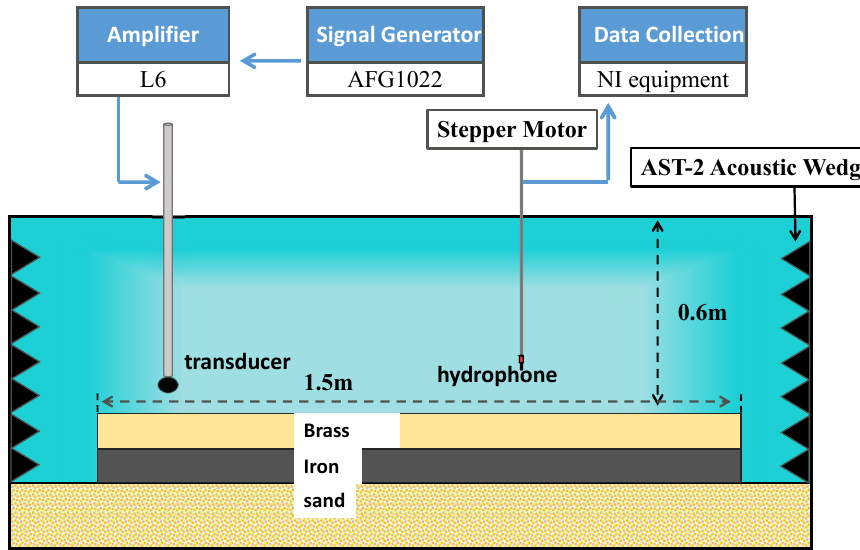
Figure 5. Diagram of the experimental system setup.